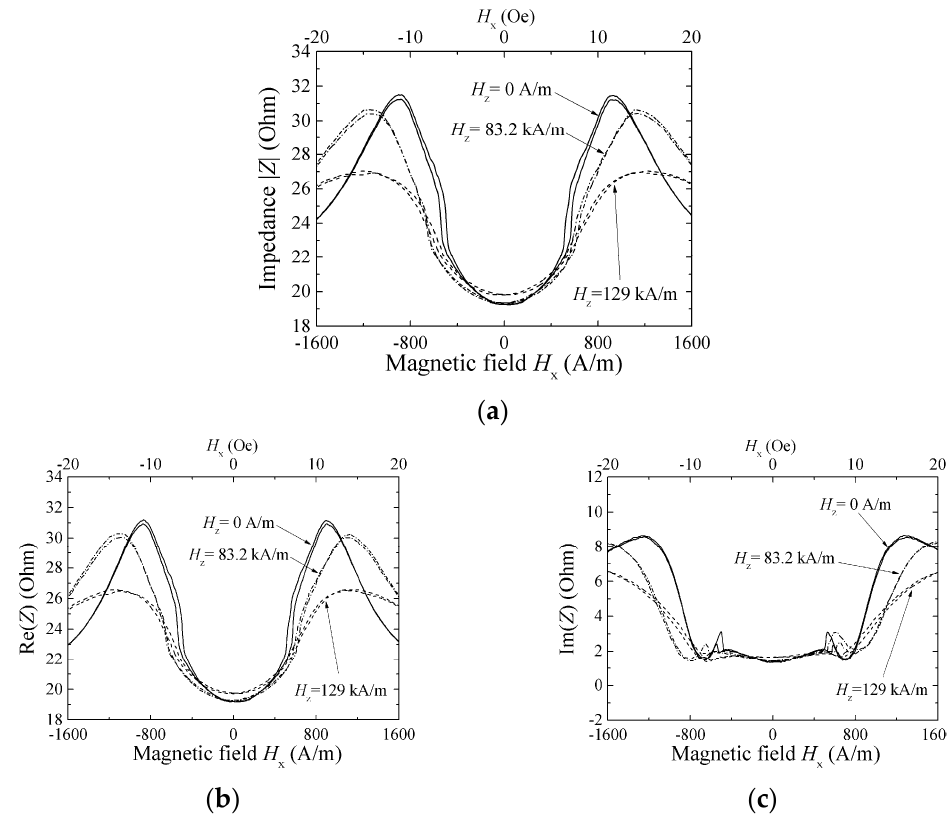
Figure 13. Variation of sensor impedance as a function of external field in X direction. Element dimensions, length: 1000 μ m, width: 50 μ m. Measurement frequency: 500 MHz. ( a )|Z|, ( b ) Re(Z), and ( c ) Im(Z) [21].